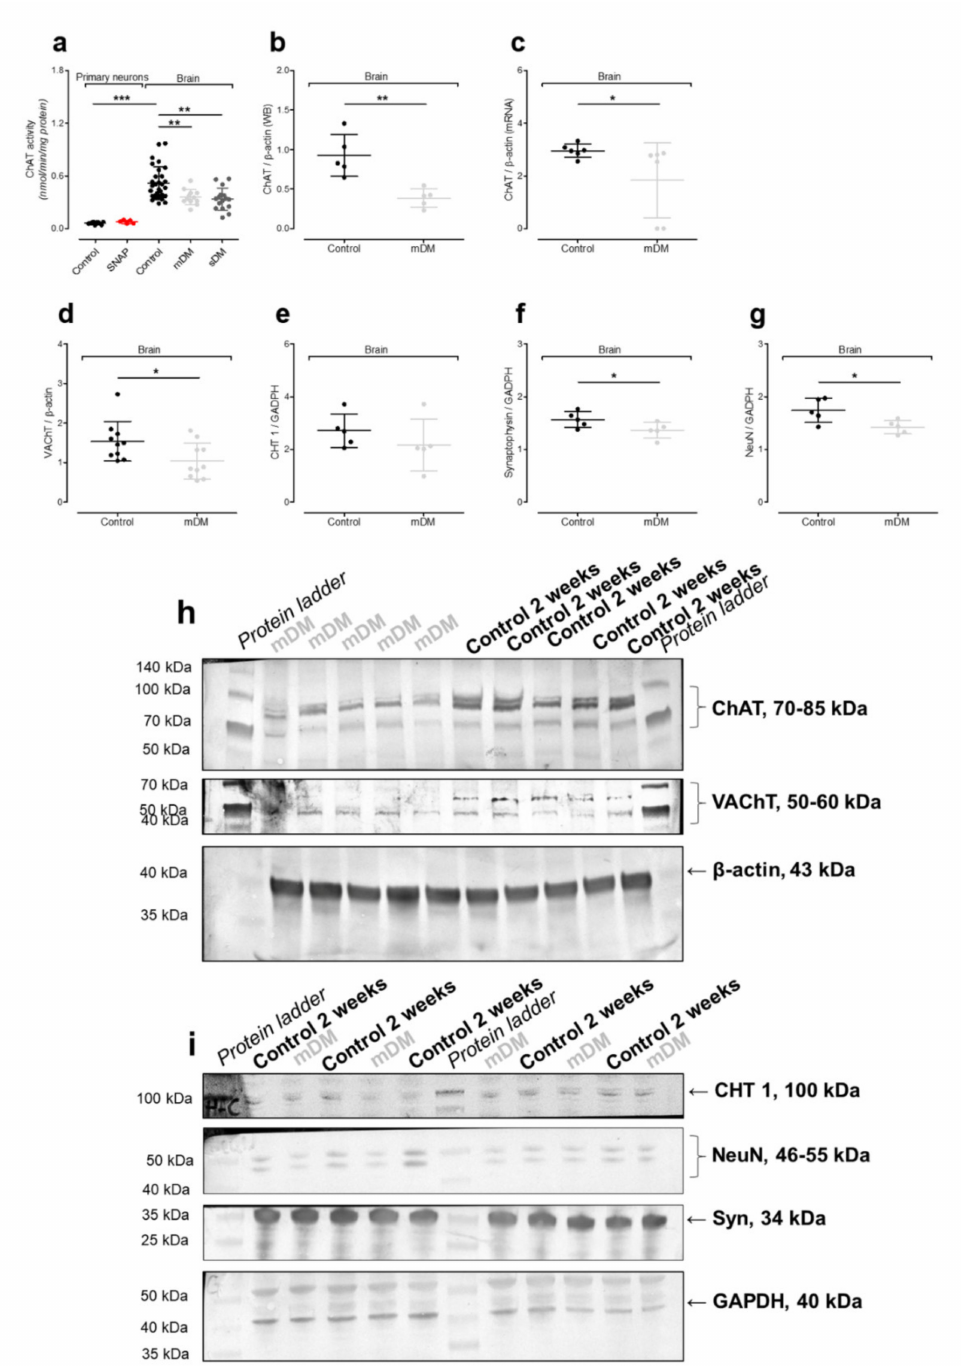
Figure 7. The impact of toxic factors on the neurotransmission markers measured in the primary neurons (PR) or the rats’ brain tissues (Brain). ( a ) ChAT activity; ( b ) choline acetyltransferase (ChAT) protein level (Western blot); ( c ) Chat mRNA level (real-time RT-qPCR); ( d ) vesicular acetylcholine transporter (VAChT) protein level (Western blot); ( e ) high-a ffi nity choline transporter (CHT 1) protein level (Western blot); ( f ) synaptophysin (Syn) protein level (Western blot); ( g ) NeuN protein level (Western blot); ( h ) representative WB membrane images for ChAT, VAChT, and β -actin proteins; ( i ) representative WB membrane images for CHT 1, NeuN, Syn, and GAPDH proteins. Data are means ± SD from 3 to 16 observations per group. Significantly di ff erent from the control: * ( p –value < 0.05), ** ( p –value < 0.01), *** ( p –value <